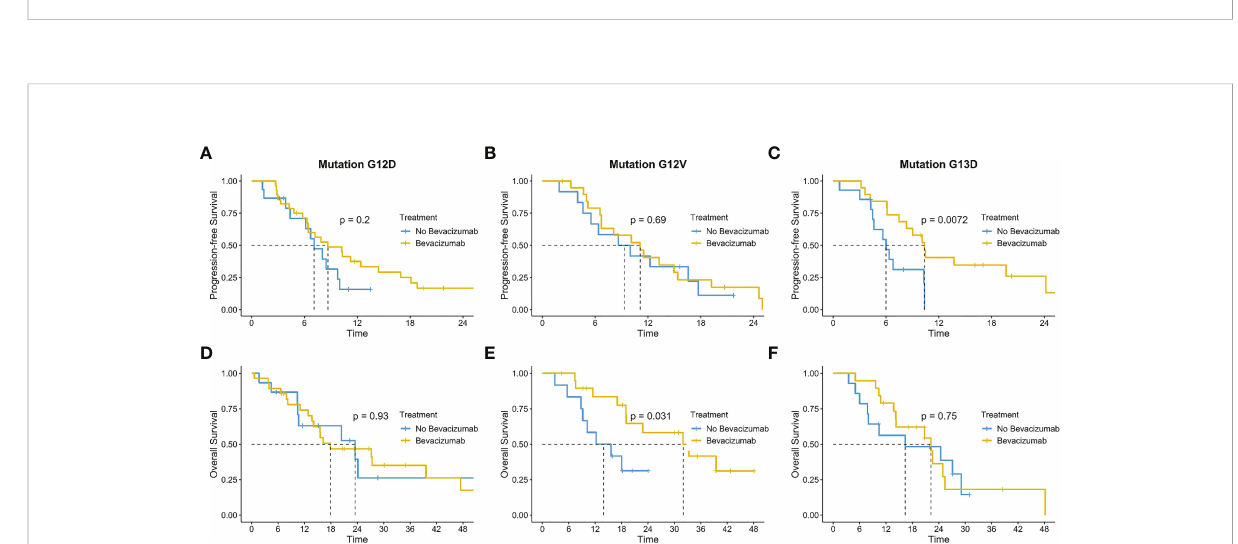
FIGURE 7 Impact of bevacizumab according to the most frequent mutation detected G12D (A, D) , G12V (B, E) and G13D (C, F)